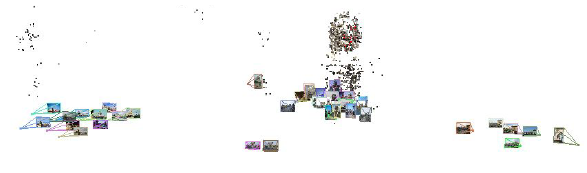
Figure 7. Reconstruction of the Lion on the Chain Bridge with the camera positions and orientations